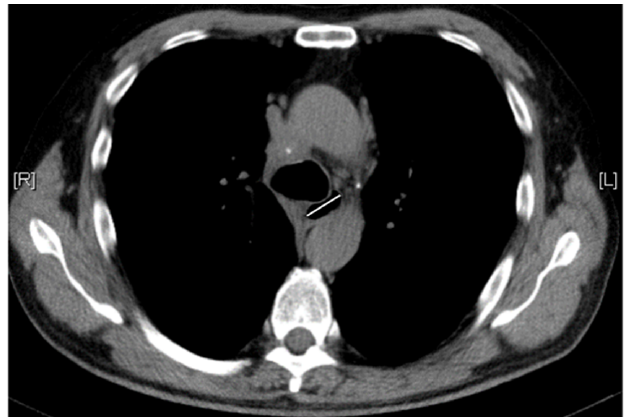
Figure 1. Widest esophageal diameter (WED) assessment (white line) on chest high-resolution computed tomography scans.